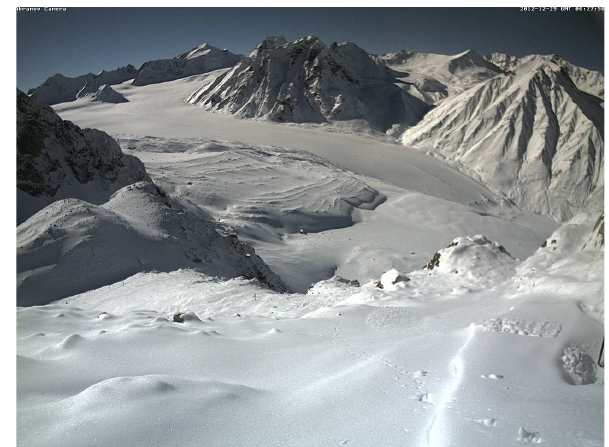
Fig. 9: Picture taken from Abramov station (ABRA) Camera #2 (29-DEC-2012) 2 Fig. 9. Picture taken from Abramov station (ABRA) Camera #2 (29 December 3